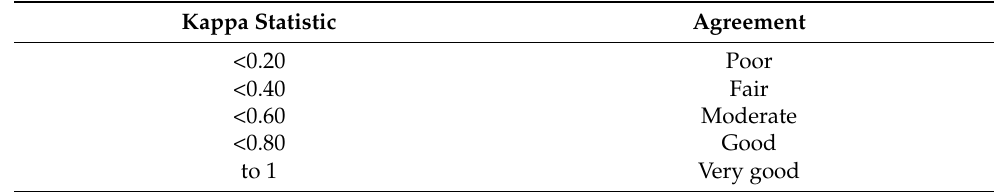
Table 1. Brief summary of common standard cognitive tests for dementia and AD diagnosis. Kappa